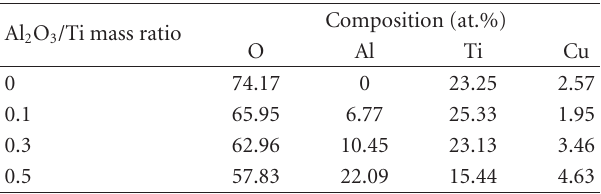
Table 2: Atomic percentage of synthesized TiO 2 nanoparticles based on XPS